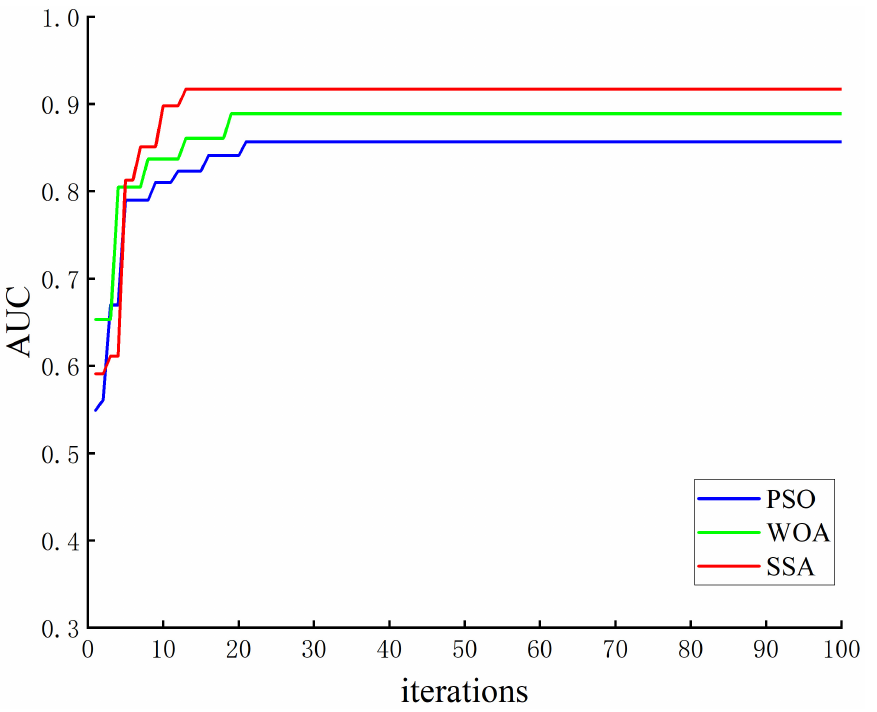
Figure 9. Fitness curve of each optimization algorithm.